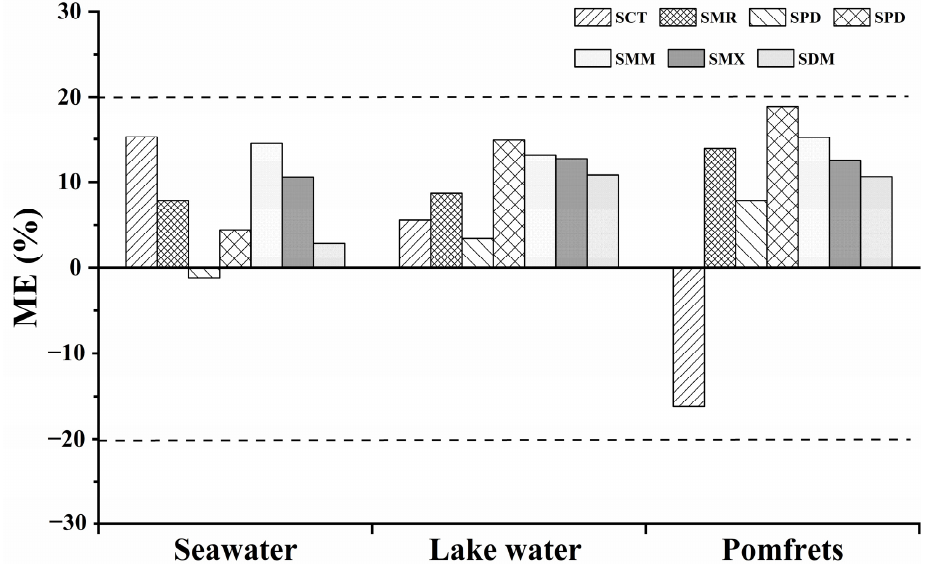
Figure 4. Matrix effect values for the seven SAs in seawater, lake water and pomfrets samples ( n = 5).